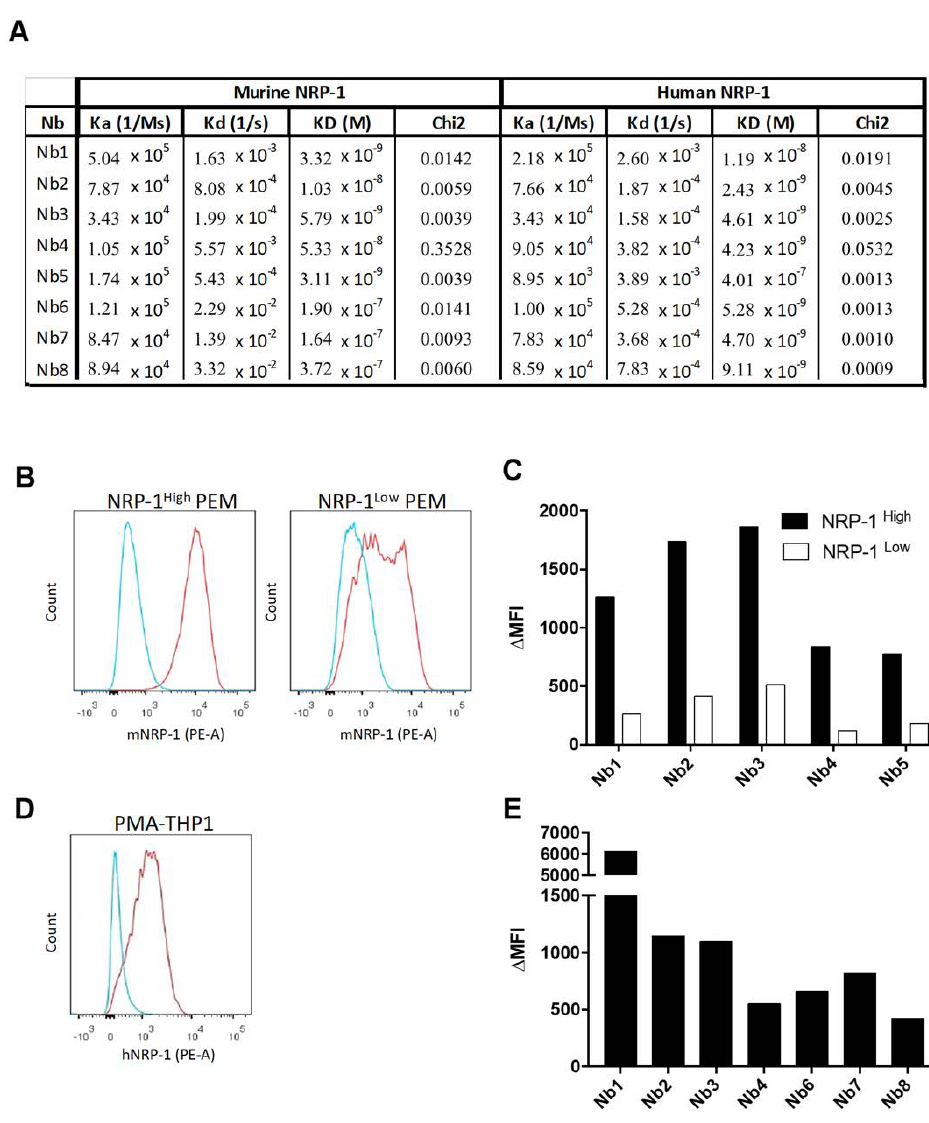
Figure 1. Selection and characterization of neuropilin-1 (NRP-1)-specific Nbs. ( A ) Association (Ka), dissociation (Kd) and equilibrium (K D ) constants of the di ff erent nanobodies (Nbs) towards recombinant murine and human NRP-1 are extrapolated through bio-layer interferometry-based Octet. Model fitting chi-square values are also shown. ( B ) Expression of mouse NRP-1 (red line) on peritoneal macrophages (PEMs) isolated from Nrp-1 FL / FL mice (NRP-1 high , left panel) and LysM Cre Nrp-1 FL / FL mice (NRP-1 low , right panel). The blue line represents the staining with an isotype-matched control antibody. The red line represents the staining with a phycoerythrine (PE)-conjugated NRP-1 mAb. ( C ) The graph shows the mean fluorescence intensity ( ∆ MFI) obtained after binding of the Nbs and their subsequent detection with an anti-HIS tag antibody on PEMs isolated from NRP-1 FL / FL mice (NRP-1 high , black bar) and LysM Cre Nrp-1 FL / FL mice (NRP-1 low , white bar). ( D ) Expression of human NRP-1 (red line) on phorbol 12-myristate 13-acetate (PMA)-treated THP1 cells. The blue line represents the staining with an isotype-matched control antibody. The red line represents the staining with a PE-conjugated NRP-1 mAb. ( E ) The graph shows the ∆ MFI obtained after binding of the Nbs and their subsequent detection with an anti-HIS tag antibody on PMA-treated THP1 cells. The ∆ MFI was calculated as MFI (anti-NRP-1 + anti-HIS) minus MFI (isotype control) ( n =